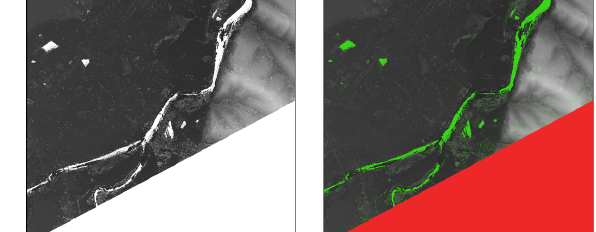
Figure 6. Left: Input DSM. Right: detected no-data areas (Red: border no-data, Green: inner